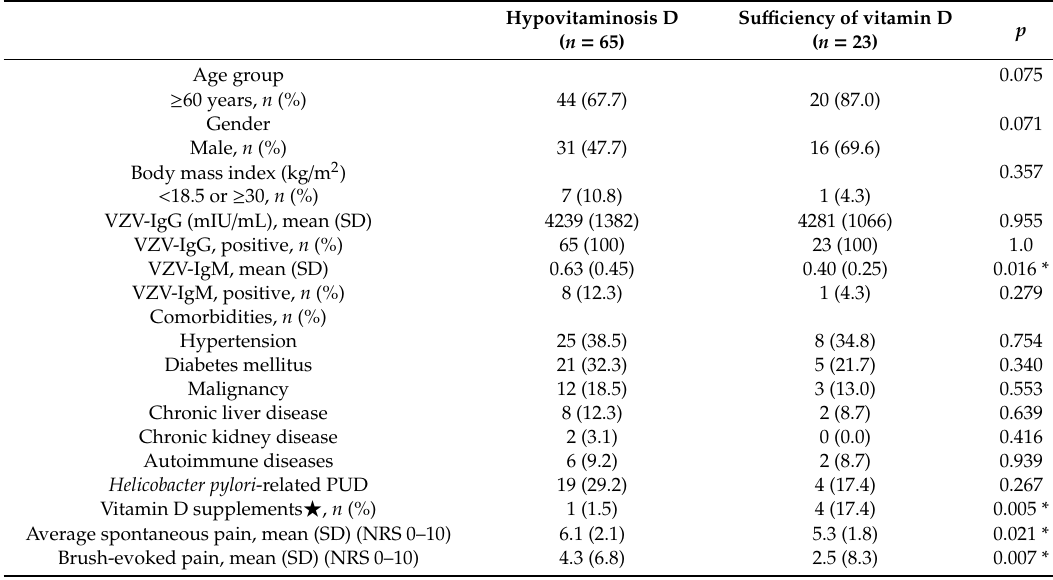
Table 2. Demographic and clinical characteristics of patients with hypovitaminosis D vs. su ffi ciency of vitamin